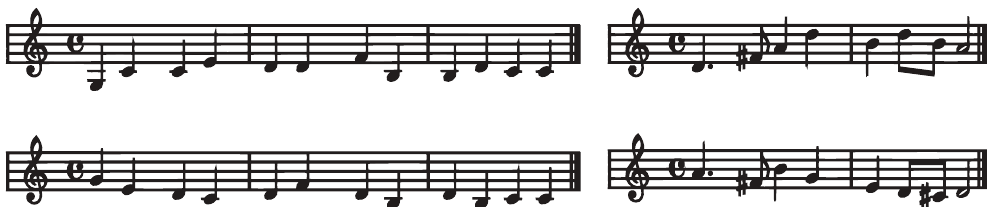
Figure 1: Overview of the stimuli used in the melodic perception (left) and rhythmic-melodic perception (right) tasks. The nursery rhyme used in the melodic perception tasks had the title “Es war eine Mutter, die hatte vier Kinder,” the one for the rhythmic-melodic perception tasks had the title “Alle V¨ogel sind schon da.” Each task had three conditions: standard (first line), transposed (first line, but played in another key), and comparable (bottom line).